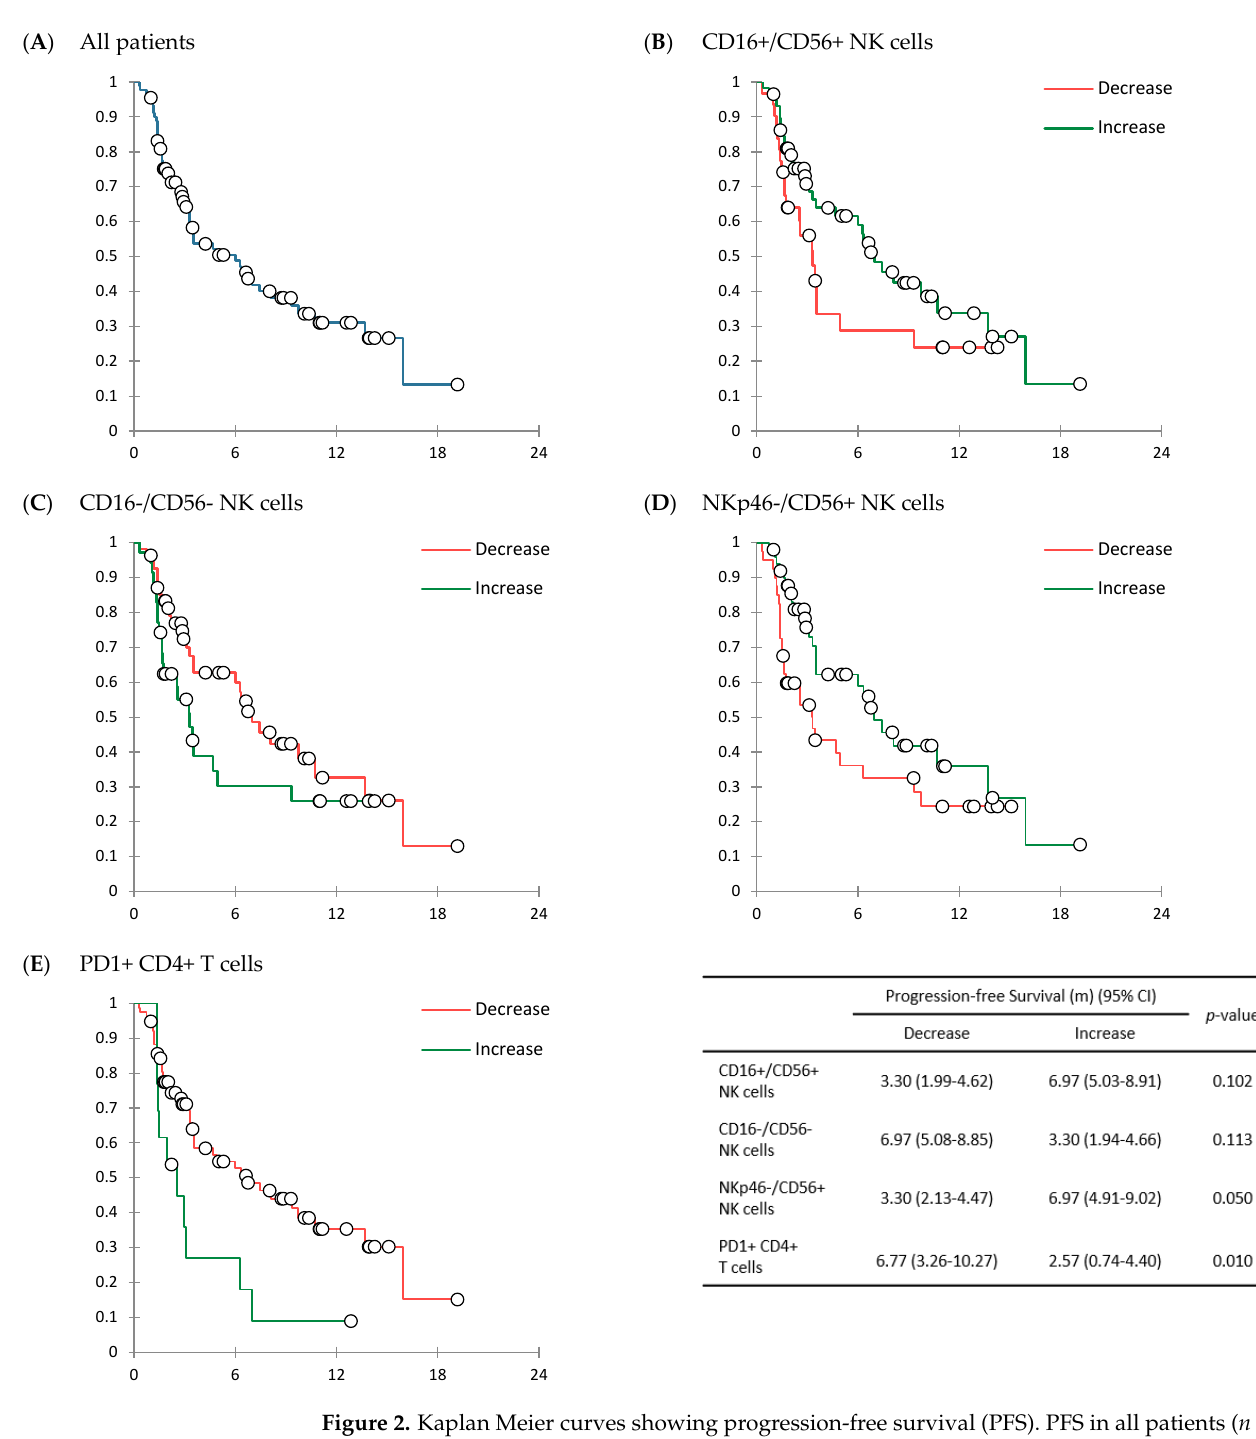
Figure 2. Kaplan Meier curves showing progression-free survival (PFS). PFS in all patients ( n = 90) ( A ). PFS comparison according to the changes in immune cell fraction; CD16+/CD56+ NK cells ( B ), CD16 − /CD56 − NK cells ( C ), NKp46 − /CD56+ NK cells ( D ), and PD-1+ CD4+ T cells ( E ).